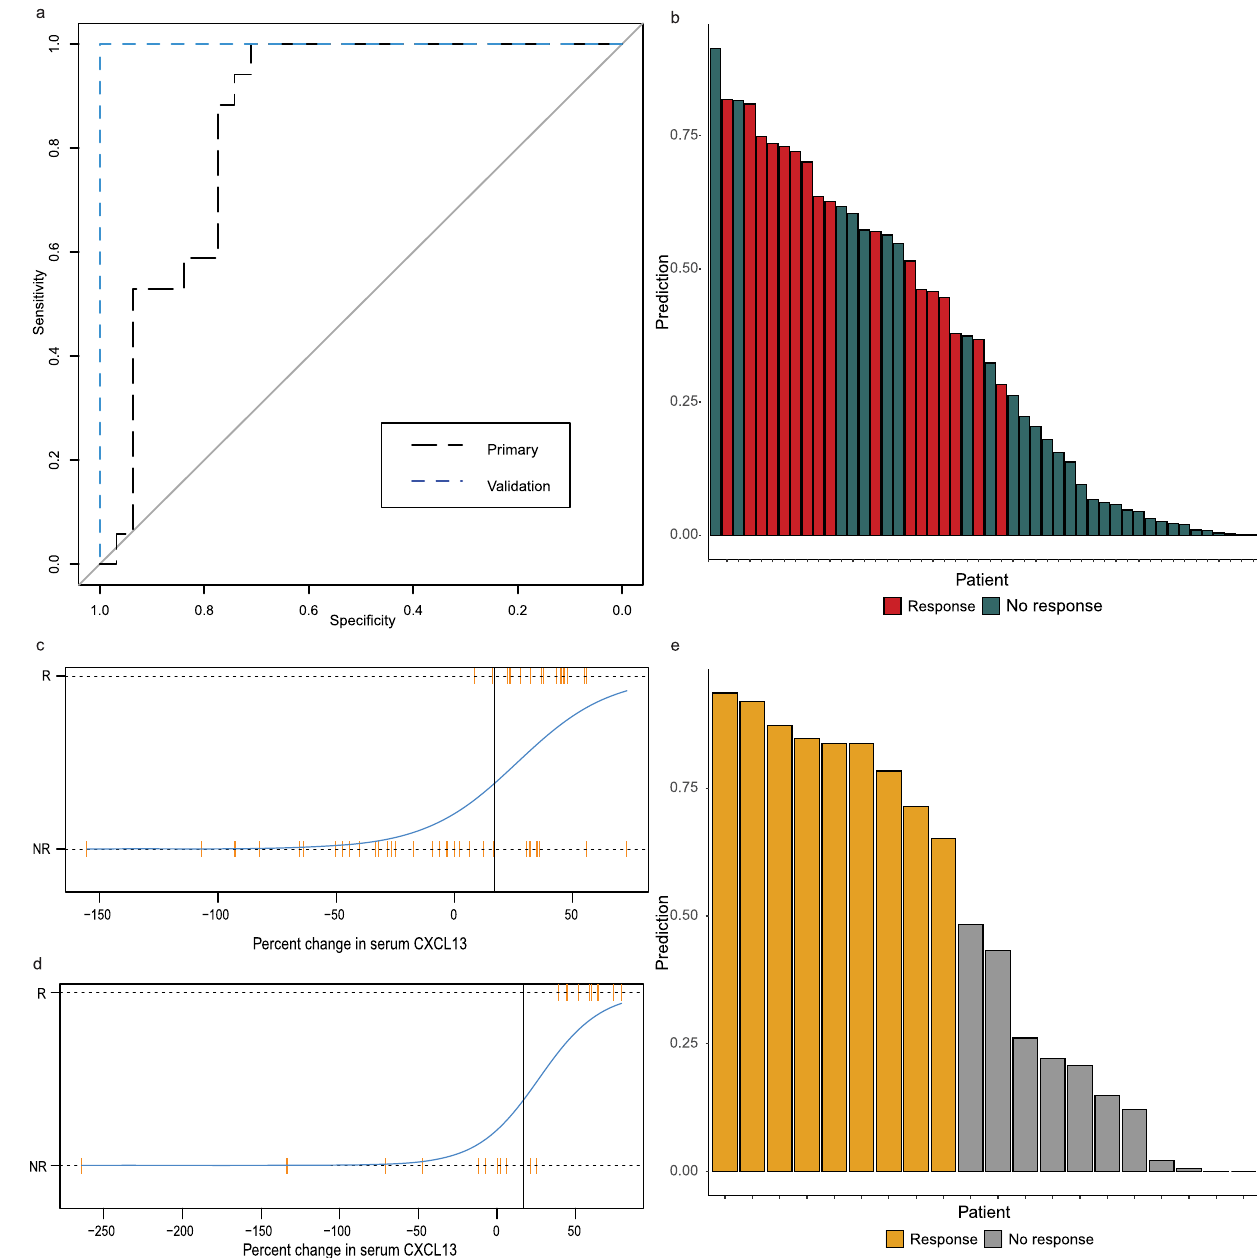
Fig. 5 | Decreased serum CXCL13 earlyin siltuximabtreatment is predictive of future response. a Receiver operating characteristic (ROC) curve for the predic- tionofsiltuximabresponsebasedonserumlevelsofCXCL13inthetrainingcohort ( n =48; 31 non-responders, 17 responders) (AUC=0.86[CI:0.753 – 0.966])) and the testcohort( n =20;11non-responders,9responders)(AUC=1.0) b Waterfallplotof response prediction values by patient colored by true response status in the training cohort. c Classi fi cation by logistic regression in the training cohort. Responders plotted along the top horizontal bar and non-responders along the bottom horizontal bar. The x-axis represents the percent change in CXCL13 from